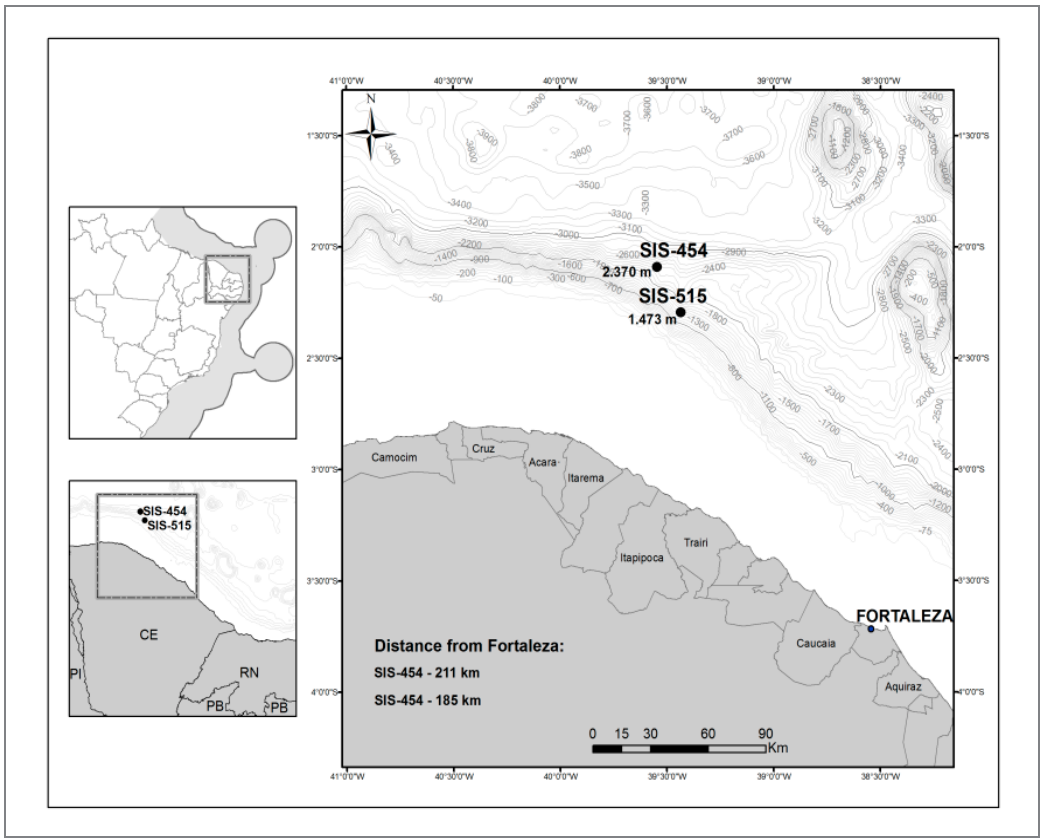
Figure 1 - Localization of deep cores SIS-515 and SIS-454 at the continental margin of the Ceará State,